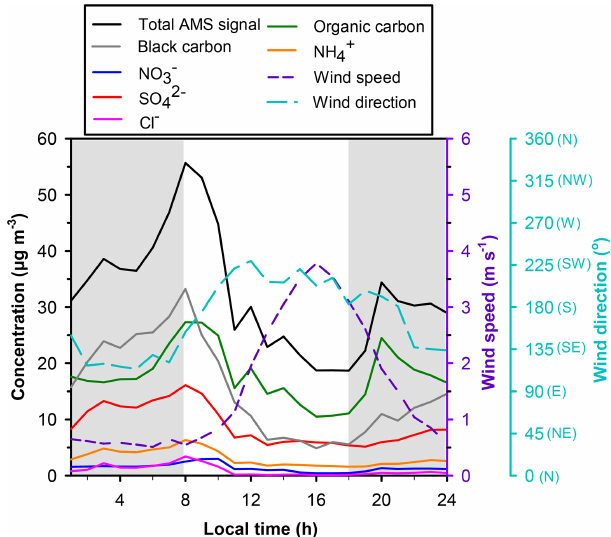
Figure 2. Diurnal trends in average total PM 1 mass and concentra- tions of non-refractory inorganic species measured with the AMS, average BC measured with the aethalometer, and average wind speed and direction at Bode on 13 and 16 to 24 April 2015. The shaded region represents the duration for nighttime filter collection and the unshaded region represents the duration for daytime filter